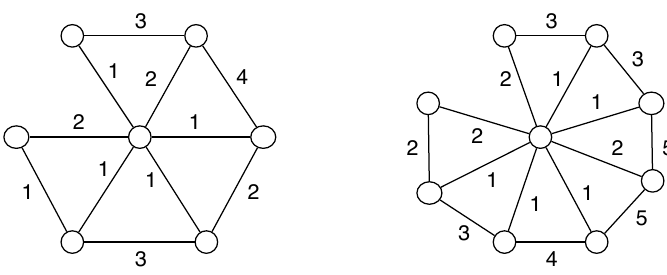
-antimagic labelings of F k